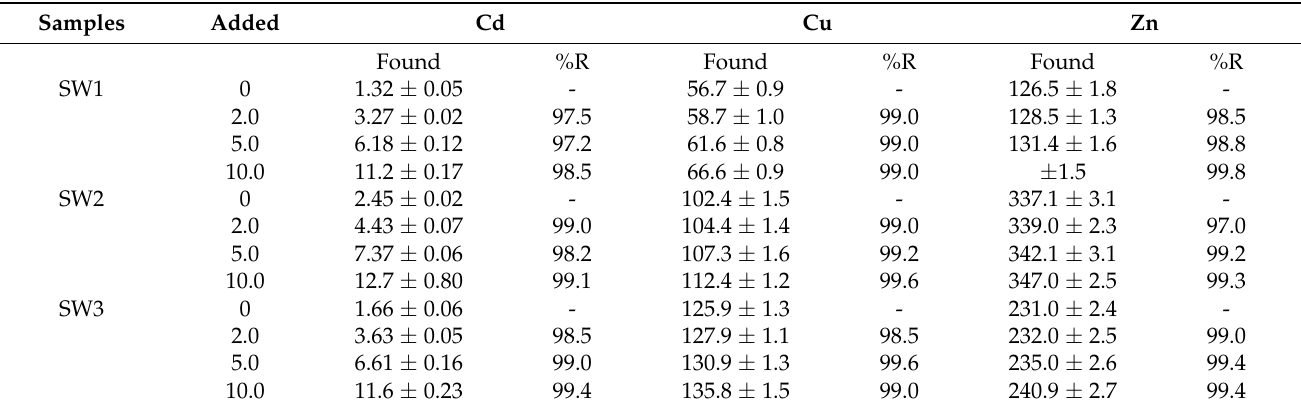
Table 4. Results for Cd, Cu and Zn ions determination in spiked surface water samples obtained under the optimum conditions (N =